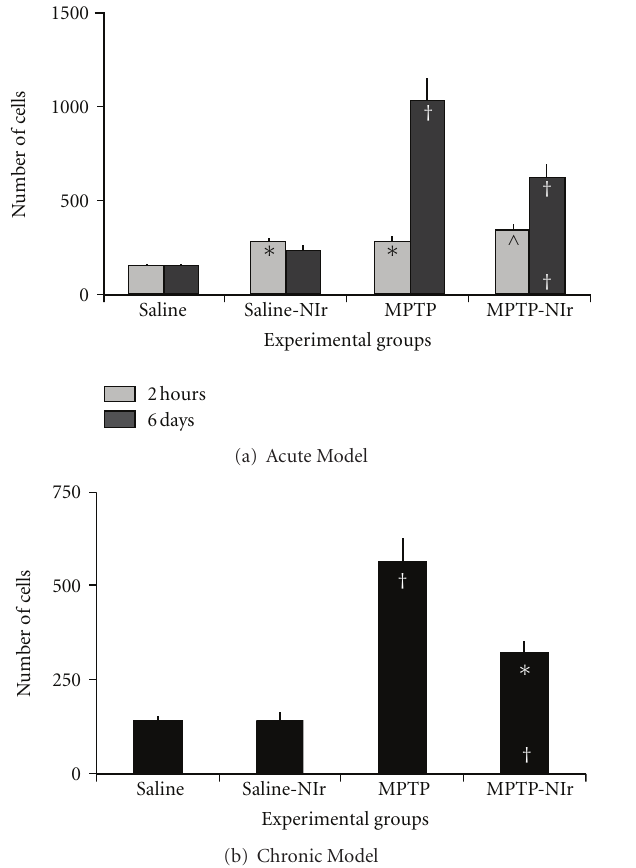
Figure 3: Graphs showing number of Fos + cells in the ZI of the four groups in the acute (a) and chronic (b) MPTP mouse models. Columns show the mean ± standard error of the total number of cells in each group. In (a) and (b), † represents P < 0 . 001 and ∧ represent P < 0 . 01 significant di ff erence in cell number between di ff erent groups (using Tukey-Kramer multiple comparison test). The symbols at the top of each column represents di ff erences with the saline group, while the symbols at the bottom of MPTP-NIr group column represent di ff erences with the MPTP